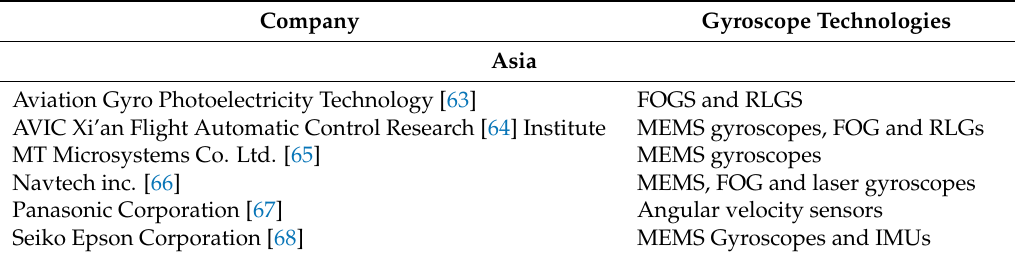
Table 2. Main players for gyroscope